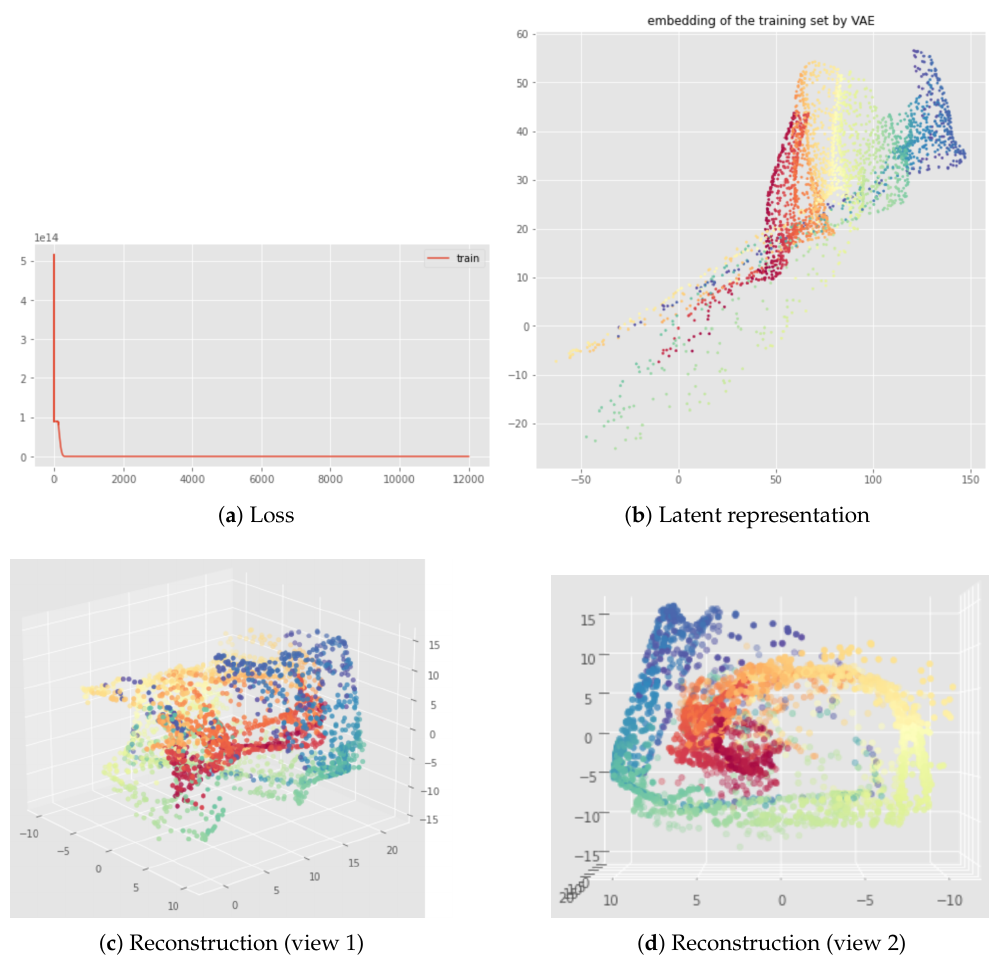
Figure 22. Isolandmarks Witness Simplicial VAE applied to the swissroll after 500 epoch: loss ( a ), latent representation of the training set ( b ), and reconstruction of the training set ( c , d ) from different views. Hyper parameters: batch size = 128, pytorchseed = 1, 32 landmarks, r filtration = 6.12, weights w SE = w SD = 10 and w iso =